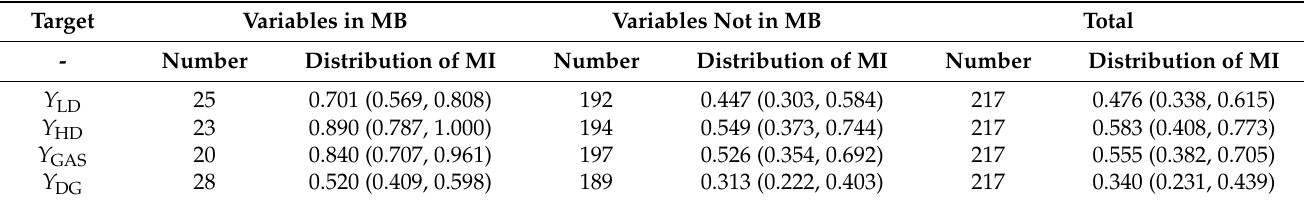
Table 3. Sizes of MBs identified and the corresponding medians and quantiles of the MI-GIEF estimates.